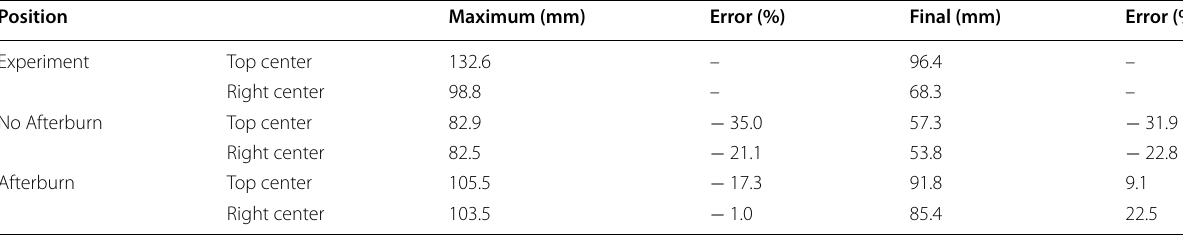
Table 4 Displacement